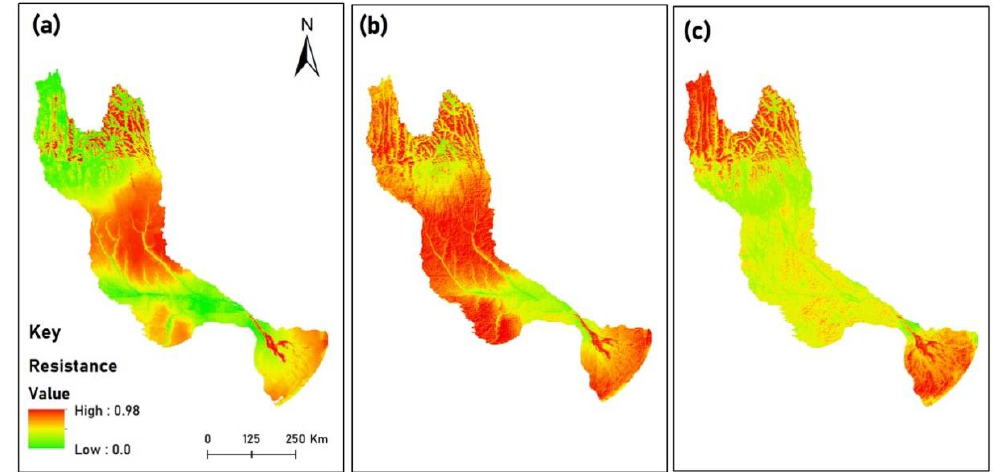
Figure 4. The map shows the LULC change resistance maps for different LULC change transitions were; ( a ) transition from natural to artificial, ( b ) transition from artificial to natural, ( c ) transition from natural-to-natural classes.